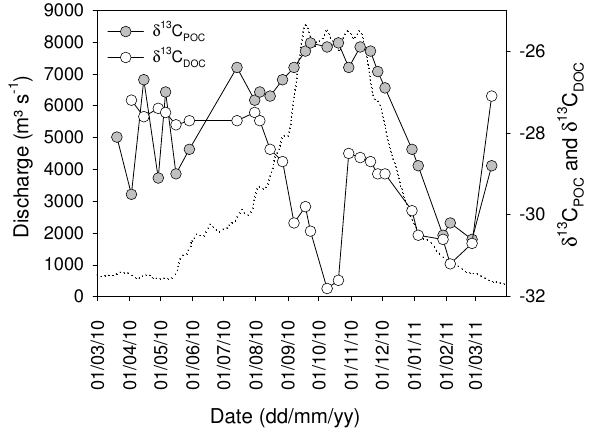
Fig. 5. Seasonal variations of daily discharge (dotted line) and δ 13 C signatures of particulate organic carbon (grey symbols) and dis- solved organic carbon (open symbols), in the Oubangui River at Bangui between March 2010 and March 2011.